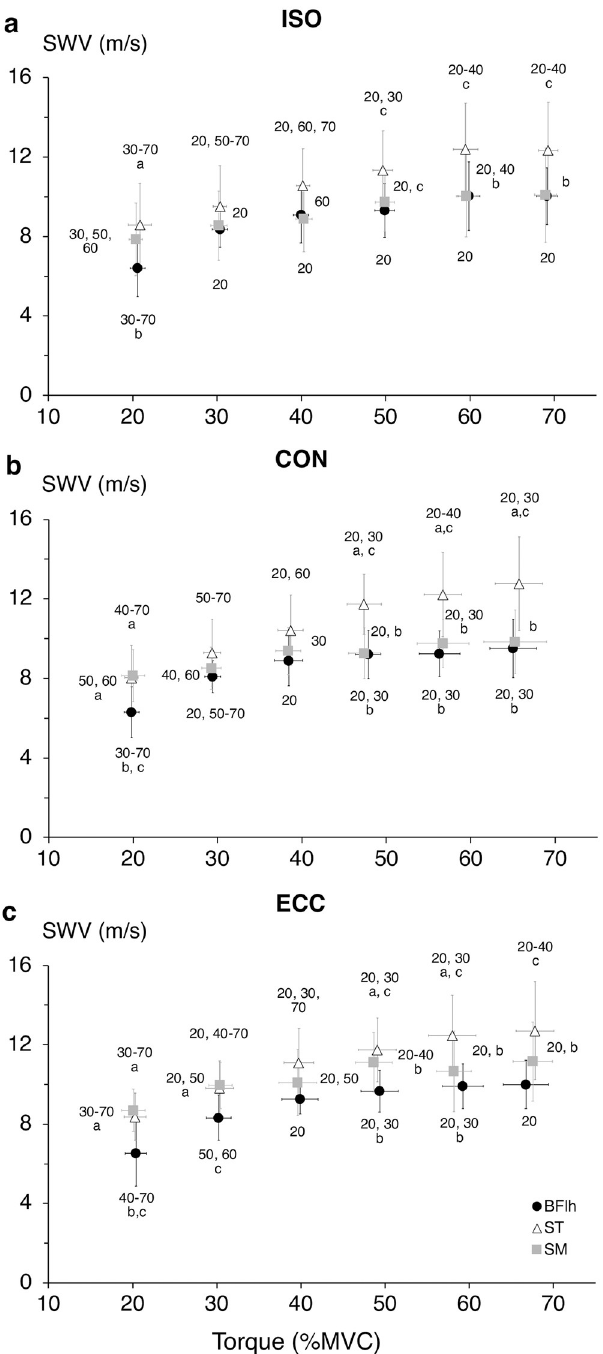
Fig 2. Between-muscles comparison of the hamstrings shear wave velocity–torque relationship for each contraction type. Comparison of the shear wave velocity (SWV)–torque relationship across the hamstrings in isometric (a), concentric (b) and eccentric (c) conditions. Data are presented as mean ± SD of the average across the duplicate measurements. Biceps femoris long head (BFlh, circles), semitendinosus (ST, triangles) and semimembranosus (SM, squares). Numbers denote difference from the respective intensity level in each muscle. a different from BFlh; b different from ST; c different from SM, p < 0.05.